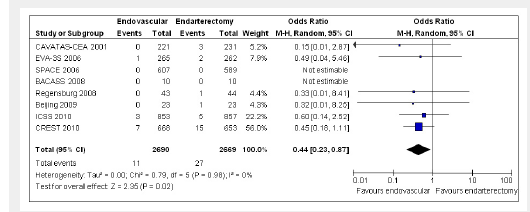
Meta-analysis of randomised trials comparing endovascular treatment with endarterectomy for symptomatic carotid stenosis: myocardial infarction between randomisation and 30 days after treatment. Data are numbers of patients with events, total numbers of patients and Mantel-Haenszel random-effects odds ratios including 95% confidence intervals (CI) with endarterectomy as the reference treatment. Squares on the right represent point estimates of odds ratios at trial level, with 95% CI as horizontal bars. The diamond at the bottom represents the summary OR and 95% CI. Data from the following trials are included: CAVATAS [13], EVA-3S